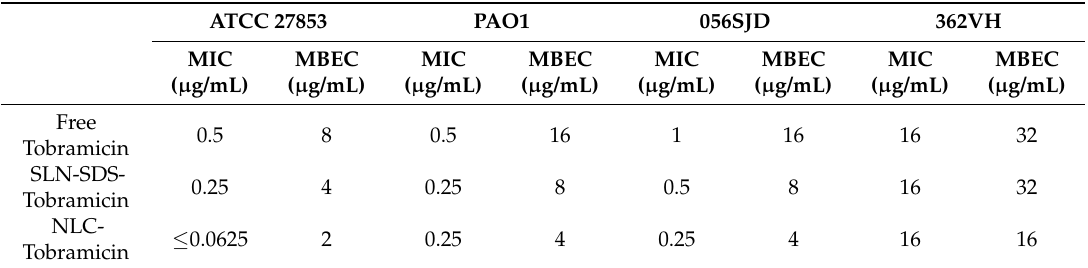
Table 3. Minimal biofilm eradication concentration (MBEC) and minimum inhibitory concentration (MIC) of free and NLC-encapsulated tobramycin. P. aeruginosa ATCC 27853 and strain PAO1 were used as controls. Strains 056SJD (non-mucoid, tobramycin-susceptible) and 362VH (mucoid, tobramycin-resistant) served as the Pseudomonas . ATCC 27853 PAO1 056SJD 362VH